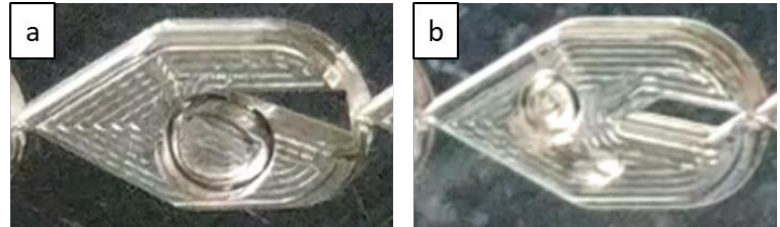
Figure 5. Flow in LL-Triangle ( a ) demonstrating increased gas holdup in the center of the mixer, a